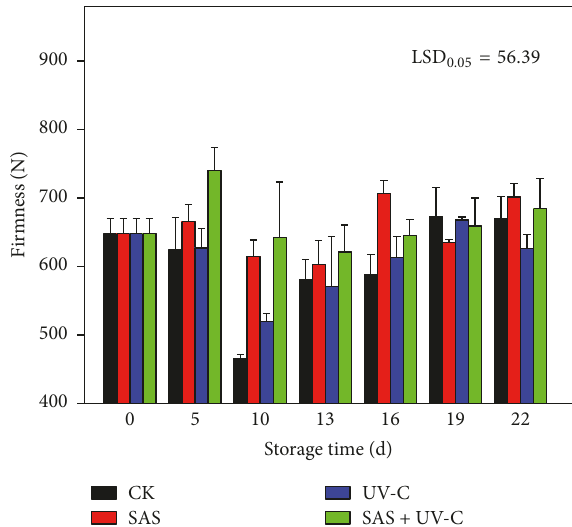
Figure 1: Effects of SAS, UV-C, and SAS + UV-C on firmness of fresh-cut potatoes during storage. The error bars represent the standarddeviation.LSDsrepresentleastsignificantdifferencesatthe 0.05